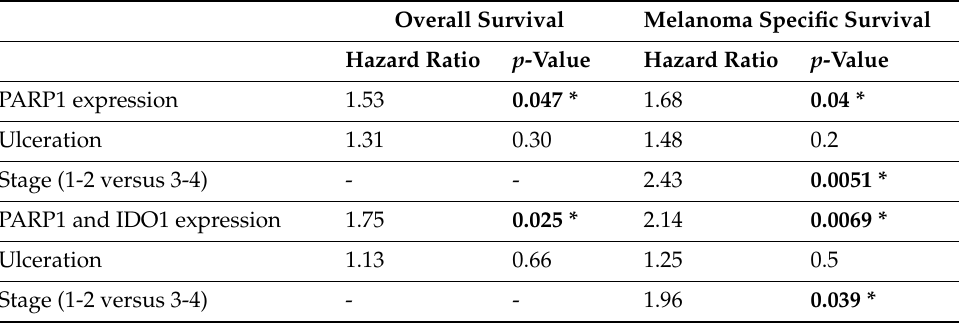
Table 3. Multivariate Cox proportional hazards